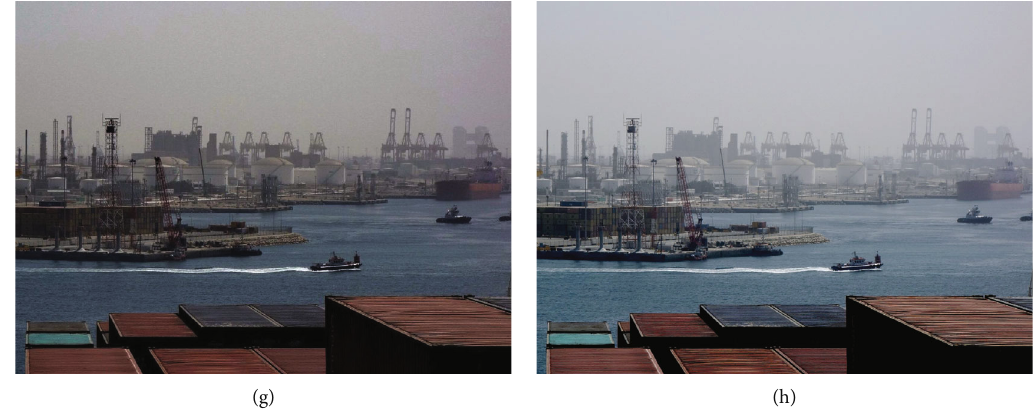
Figure 9: Comparison experiment of di ff erent methods on real hazy images in marine ports. From top to bottom: (a) real hazy image and restored images, generated by (b) DCP [19], (c) nonlocal [37], (d) F-LDCP [20], (e) AODNet [25], (f) GCANet [26], (g) MSCNN [24], and (h) ours,